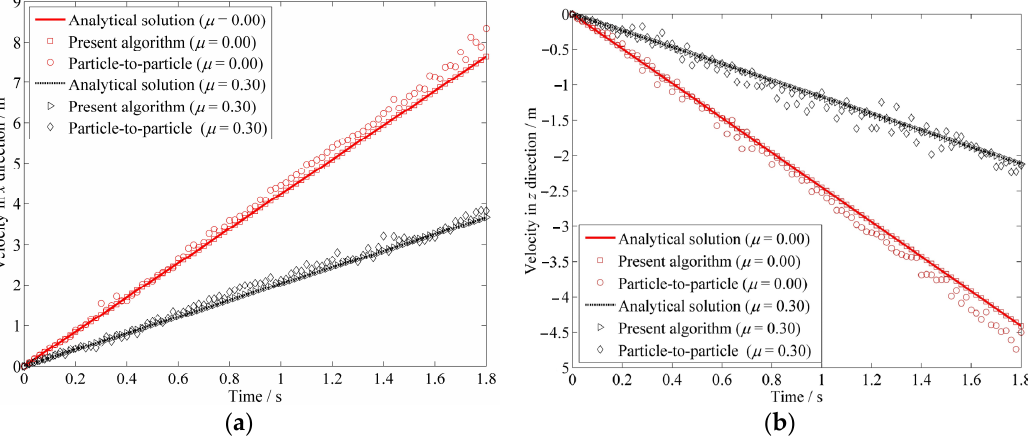
Figure 9. Comparison of the velocities of the block calculated by the present algorithm and the particle-to-particle contact algorithm: ( a ) Velocity in x -direction; ( b ) Velocity in z -direction.